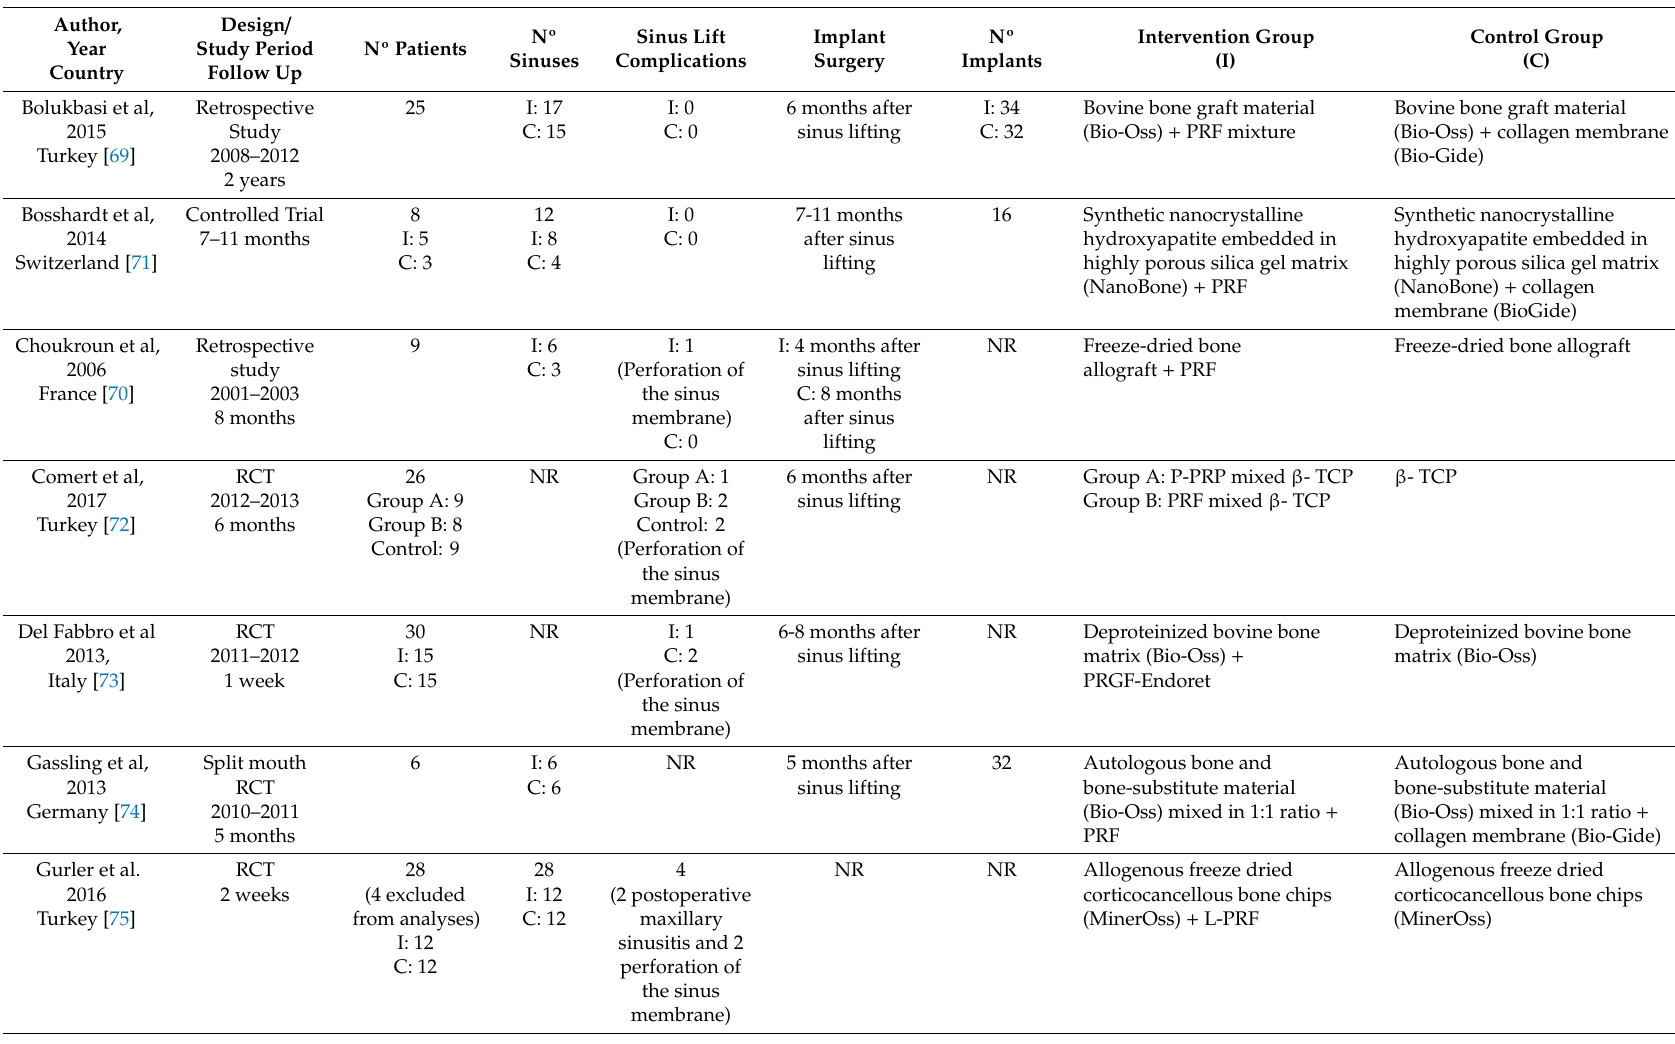
Table 2. Descriptive characteristics of studies included for the use of PRF combined with other grafting materials in sinus floor